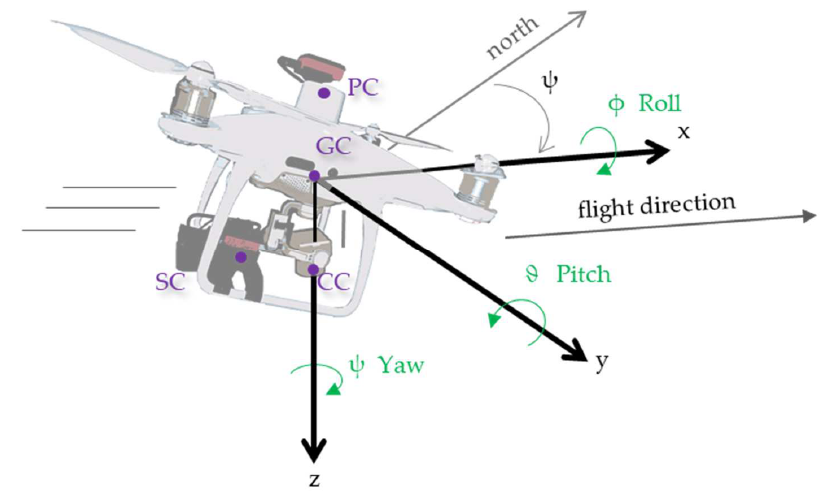
angles. Offsets in the north, east and vertical directions were in columns 4, 5 and 6 of the file, respectively. North offset was added to latitude and east offset to longitude, while vertical offset was subtracted from elevation. offset was subtracted from elevation.